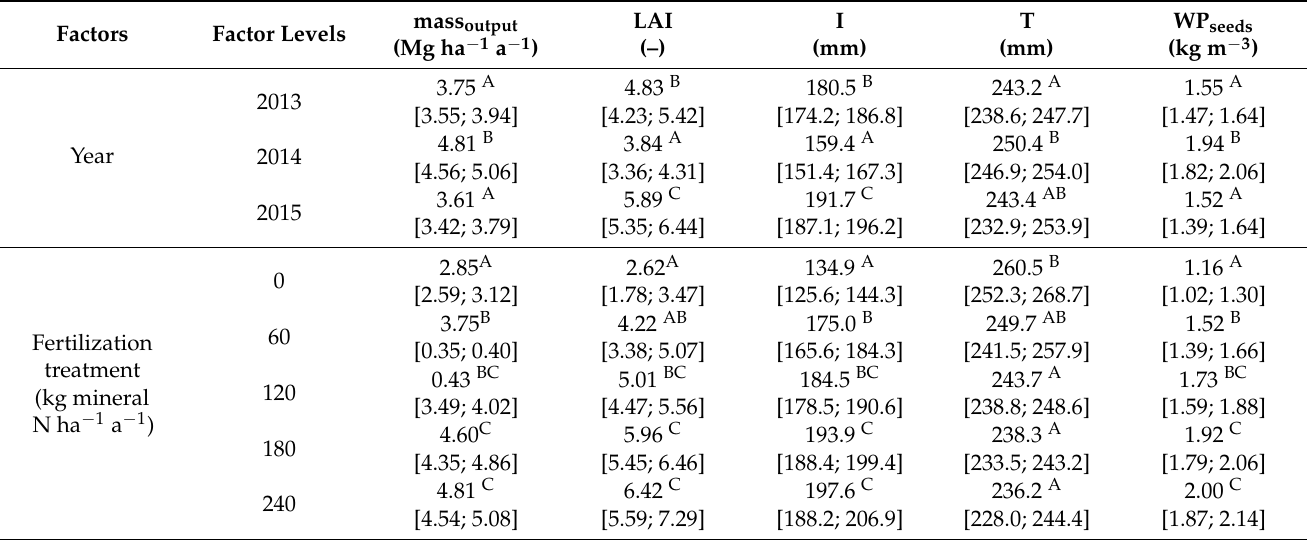
Table 3. Least square means with lower and upper 95% confidence limits of yield, LAI, evaporation from interception (I) transpiration (T), and water productivity (WP) of the five fertilization treatments 0 (N0), 60 (N1), 120 (N2), 180 (N3), and 240 (N4) kg mineral N ha − 1 a − 1 . Different upper letters within a trait indicate significant differences between the N fertilizer treatments within one year as well as between years (multiple pairwise tests with simulation adjustment, α = 0.05).